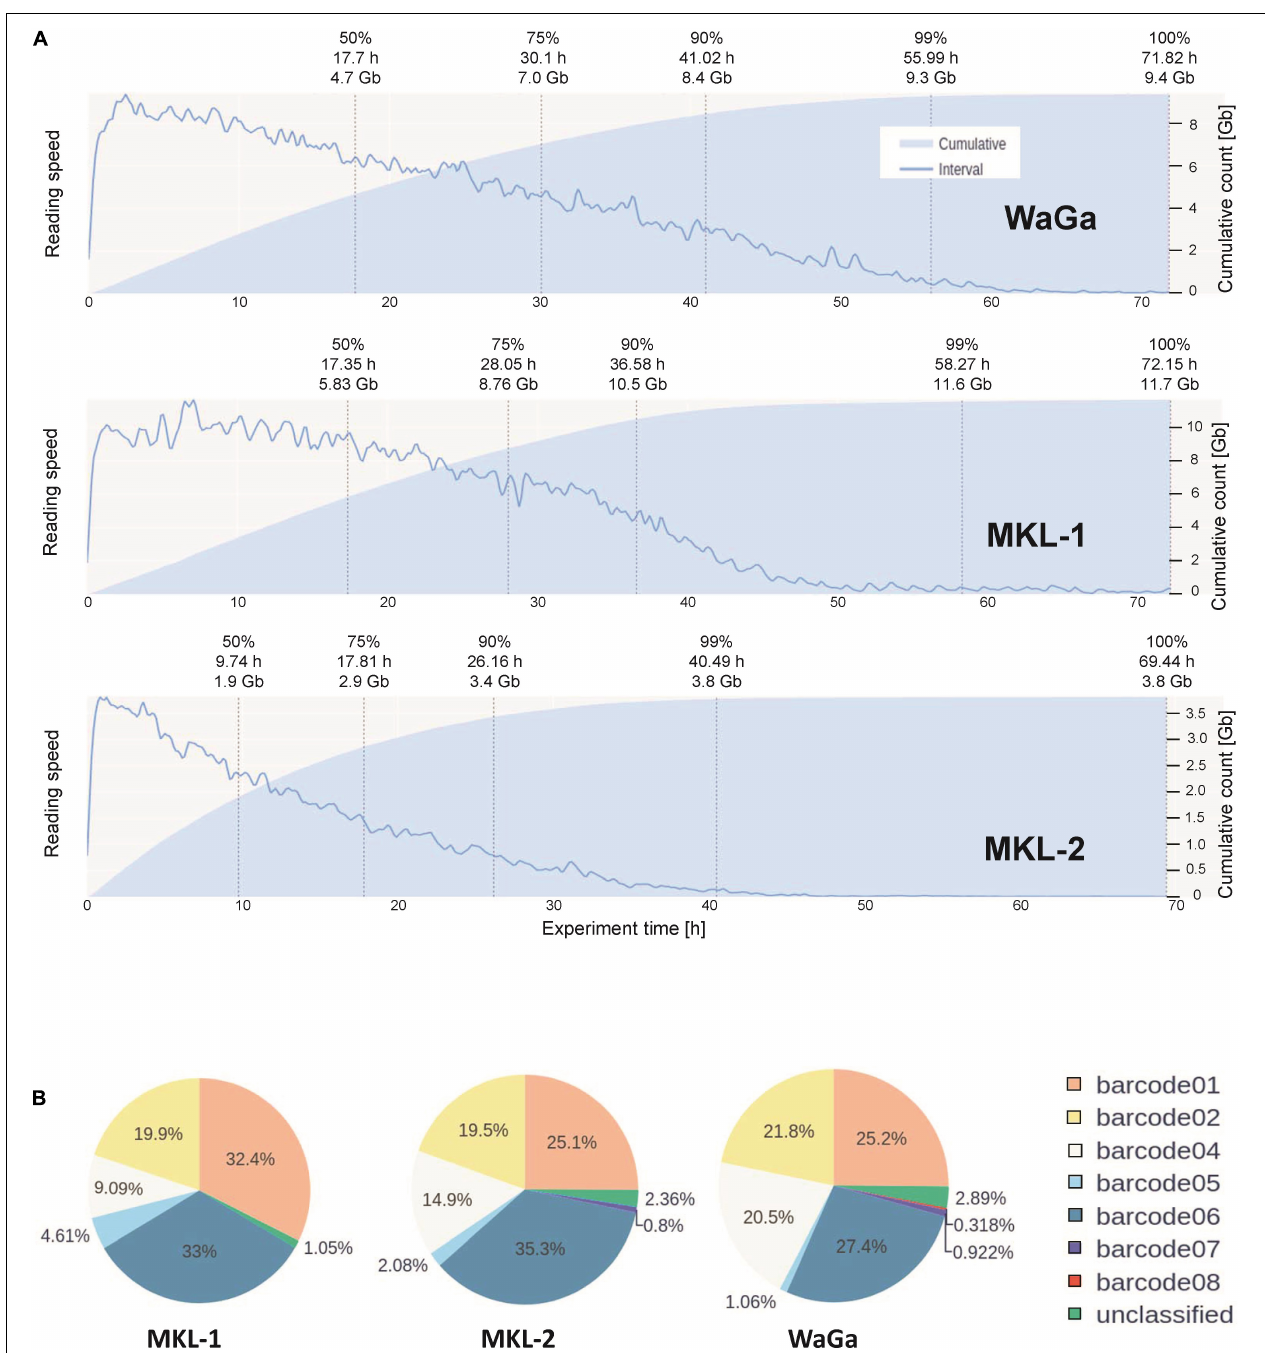
FIGURE 2 | Functional performance of the Nanopore flowcells and barcodes. (A) Depiction of output over time of MKL-1, MKL-2, and WaGa cells. For each cell line, a new flow cell was loaded with the multiplexed library. The sequencing run lasted 72 h. The blue line indicates relative reading speed, i.e., bases per time, the light blue area represents cumulative reading output. (B) Barcode distribution of detected barcodes during the sequencing run of the three cell lines MKL-1, MKL-2, and WaGa. Barcode 3 is not displayed as it failed in the first run of MKL-1 and was skipped for further experiments. In the run of WaGa, we additionally tested barcode 8, which failed similar as barcode 3. The other barcodes (1, 2, 4, 5, 6, and 7) could be used according to their performance for multiplexing